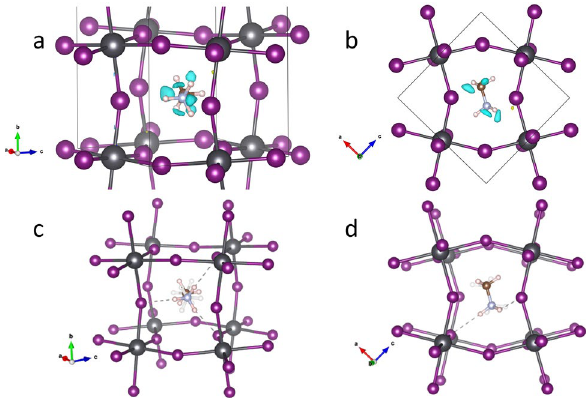
Figure 4. (Top) Two views of the orthorhombic crystal structure of MAPbI 3 , showing negative areas in the Difference Fourier Maps suggesting rotations of the MA molecule along the C–N axis ( a ) b-axis vertical ( b ) along b axis (bottom). Two views of the orthorhombic crystal structure of MAPbI 3 , highlighting the H-bond interactions with adjacent I atoms ( c ) approximately along [101] direction, ( d ) along b axis; note the in-phase tilting of the PbI 6